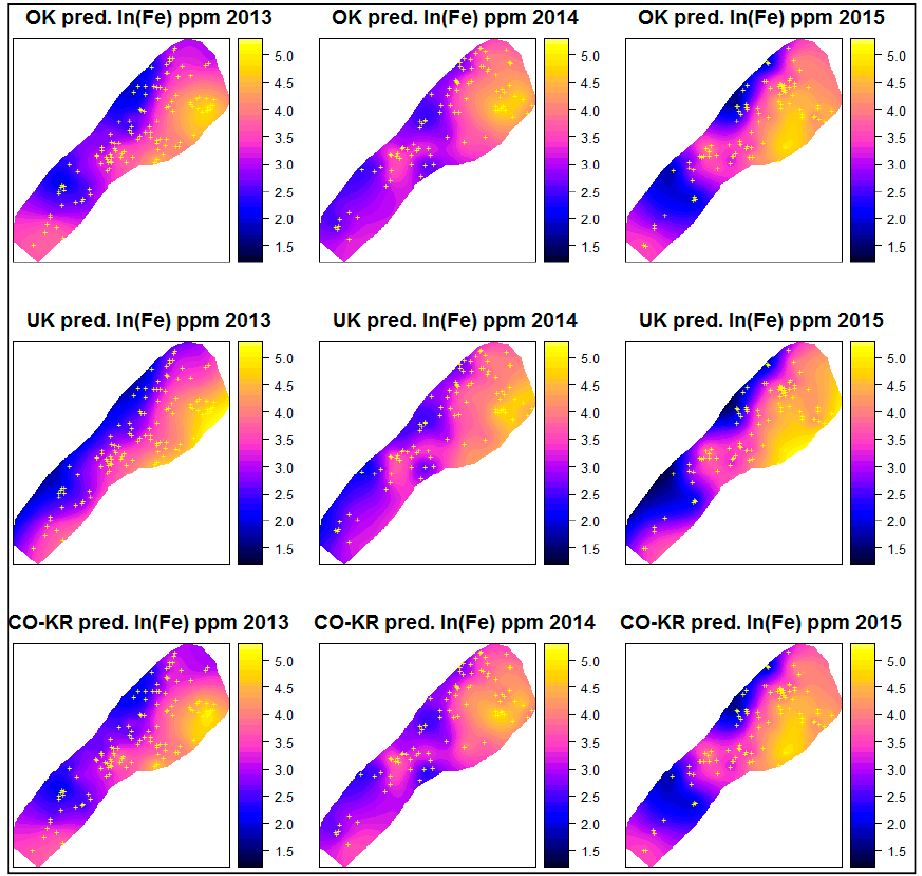
Figure 8. Prediction maps for ln(Fe) of the different interpolation methods for each year.